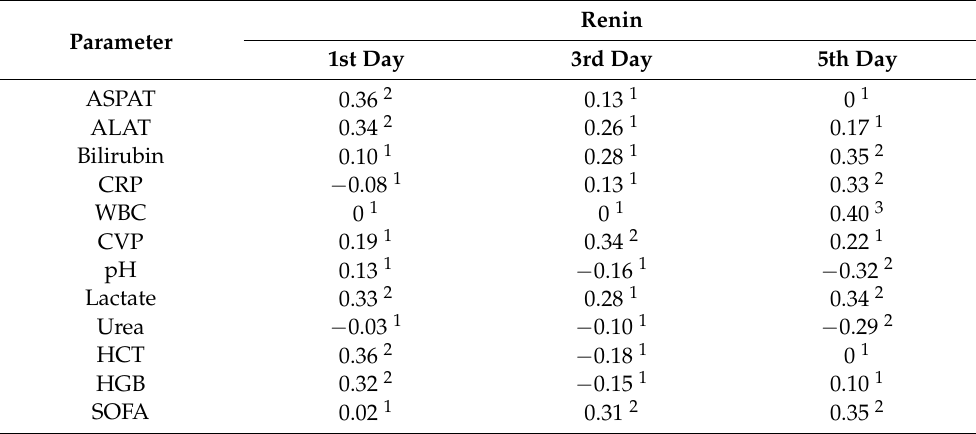
Table 2. Correlation between renin and biochemical and clinical parameters during a follow-up.